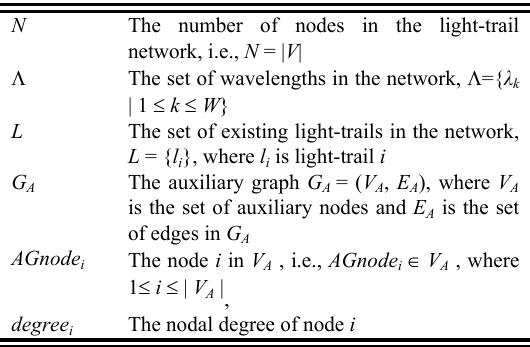
TABLE 1. Notations used in auxiliary graph generation